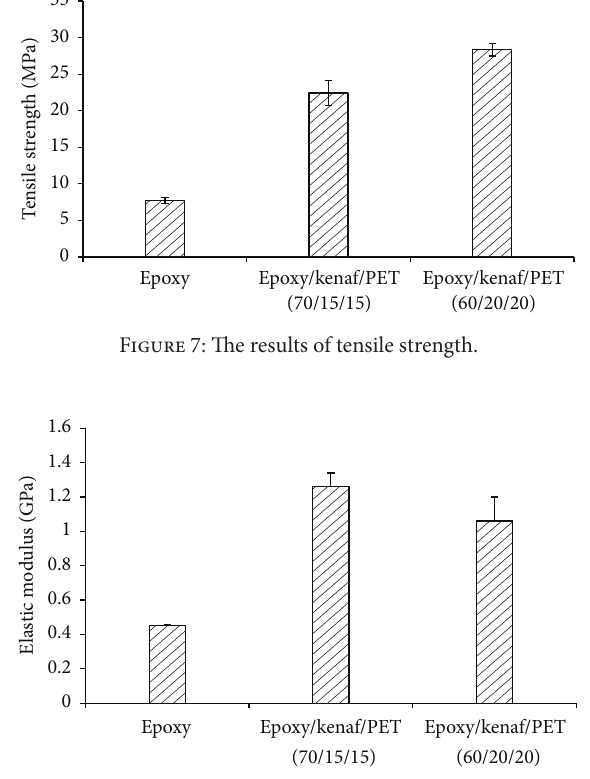
Figure 8: The results of elastic